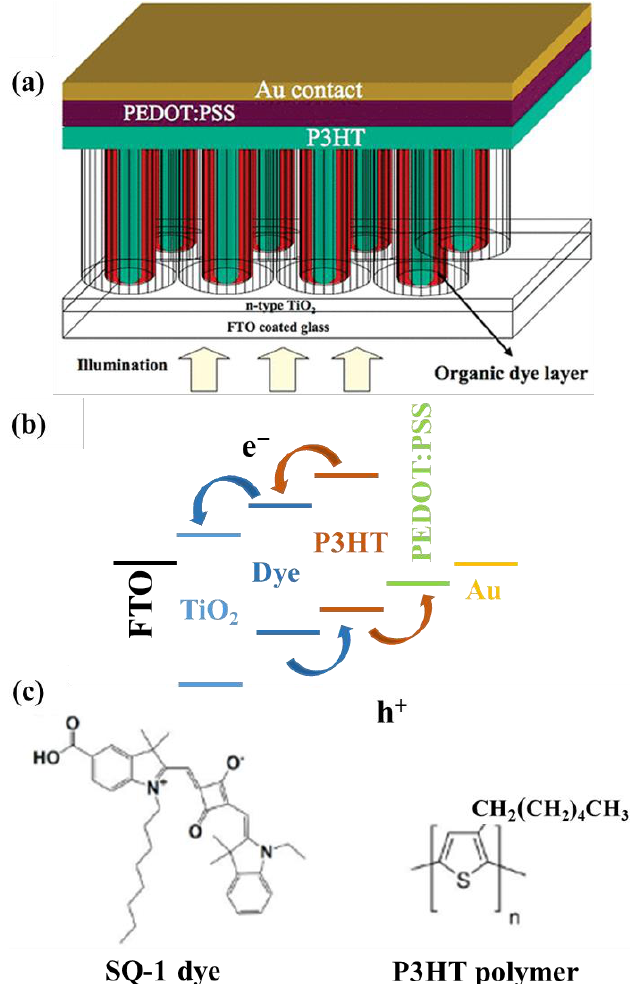
Figure 7. ( a ) Depiction of hybrid solid-state solar cell, ( b ) Energy level positions and charge transfer processes of the constituent layers of the described hybrid solar cell, ( c ) Molecular structure of SQ-1 dye and P3HT polymer. Adapted from [115] with permission from American Chemical Society™.